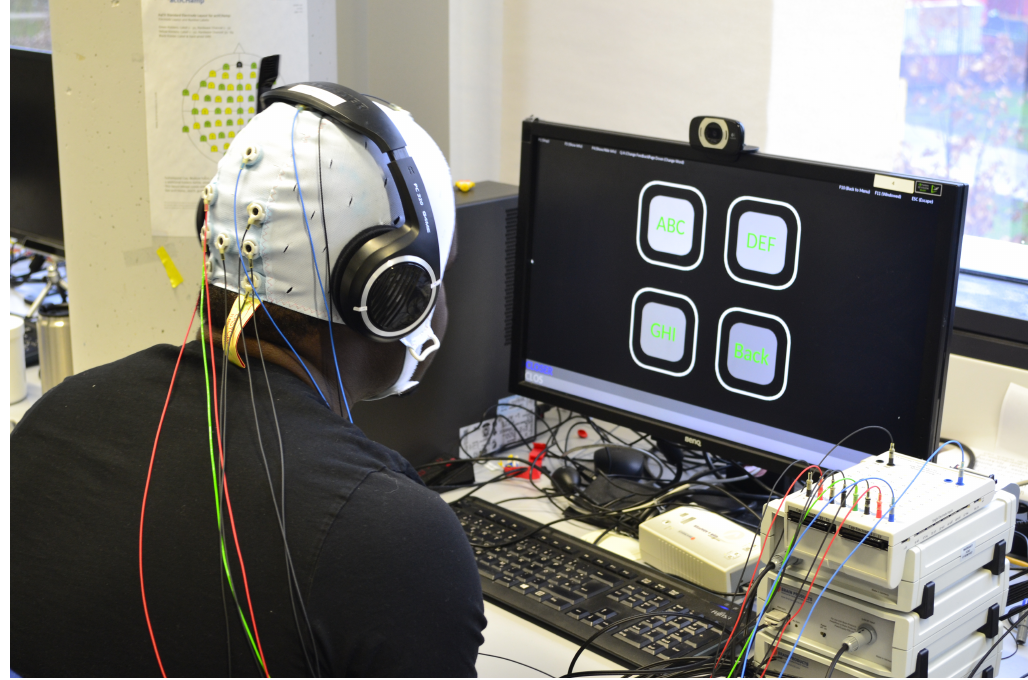
Figure 1. The setup of the experiment with the used 4-target interface. The amplifier, BrainAmp, is located to the right of the